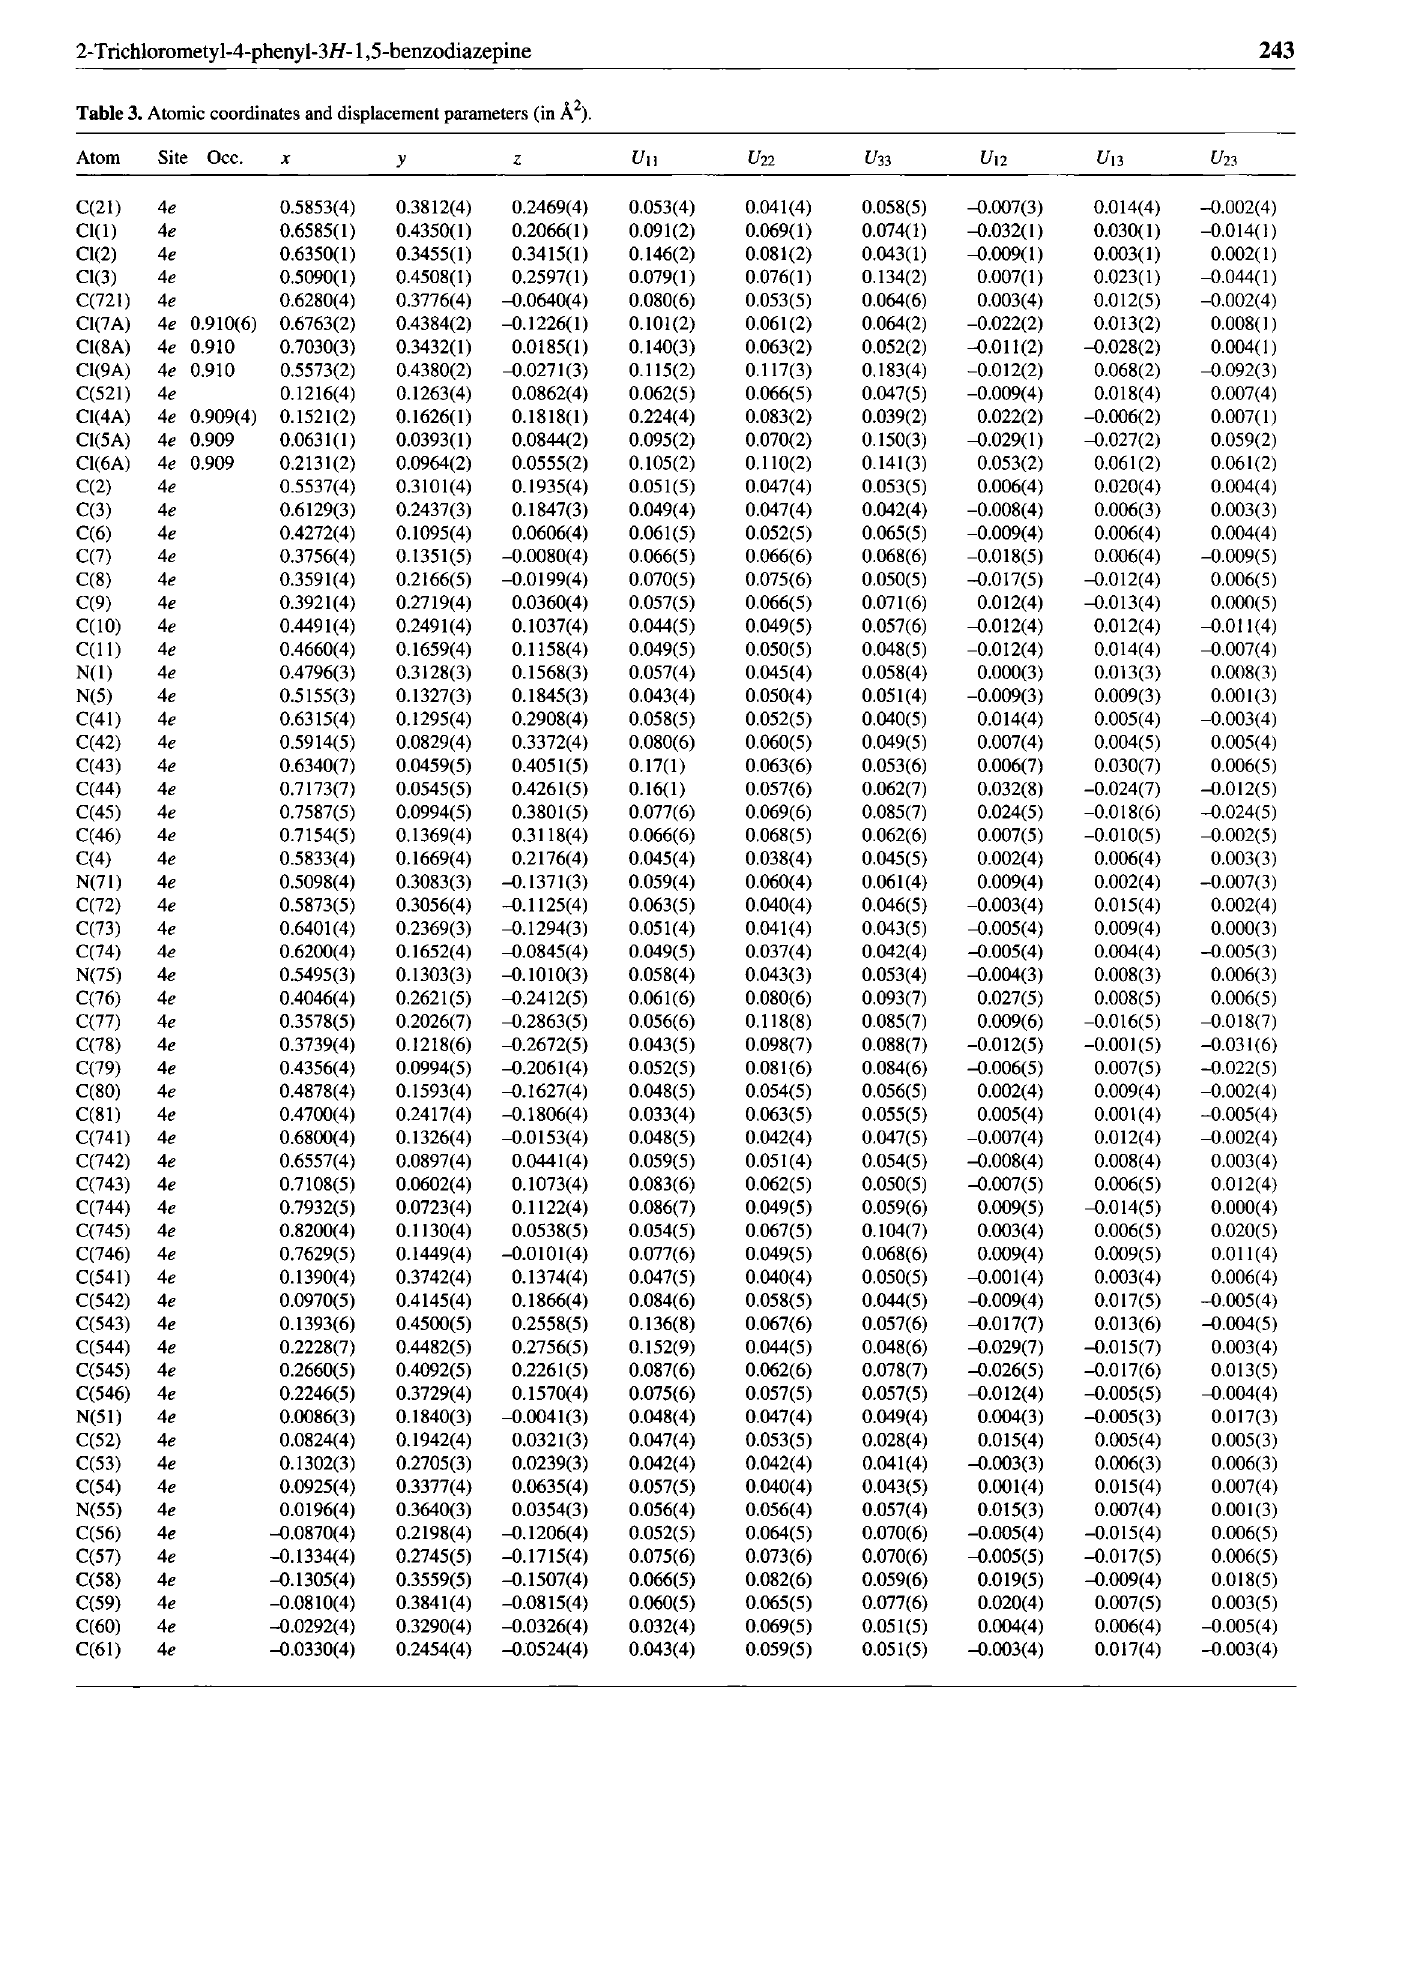
Table 3. Atomic coordinates and displacement parameters (in Ä 2 ). Atom Site